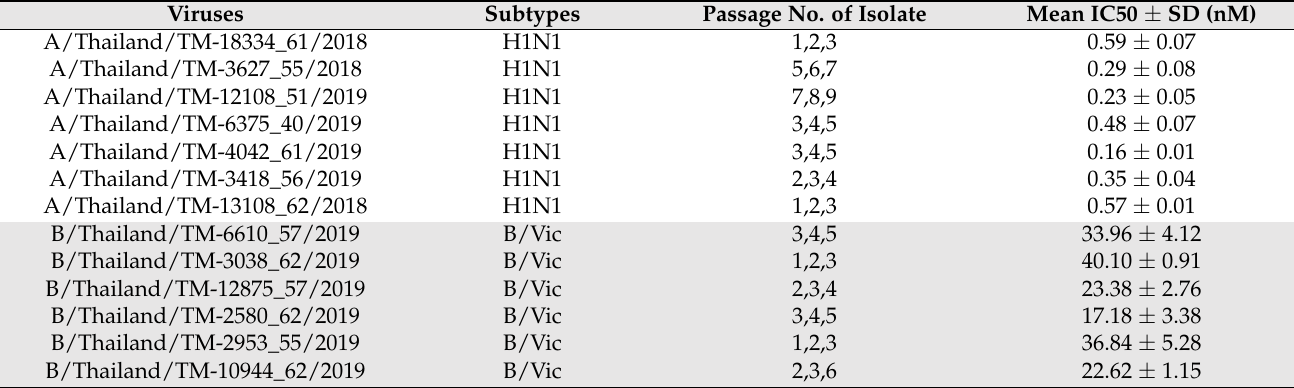
Table 2. Drug susceptibility testing by fluorescence-based neuraminidase inhibition assay.